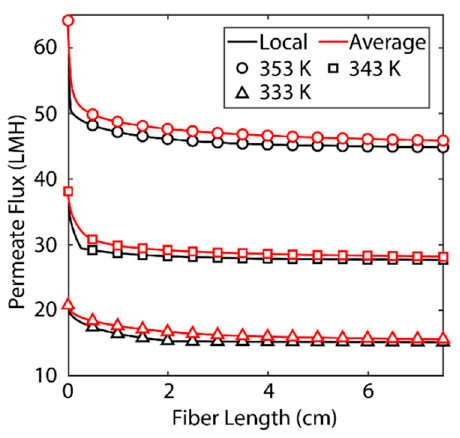
Figure 3. Localized permeate flux and average flux as a function of fiber length. Black lines indicate localized values for permeate flux at a certain distance from the fiber inlet. Red lines indicate the average permeate flux for a fiber with the length shown. The result is based on a shell-side feed, inner radius 350 µm, thickness 300 µm, R / a 0.35, feed velocity 5 m/s, vacuum pressure 5 kPa, tortuosity 2, pore diameter 400 nm, and porosity 0.5.